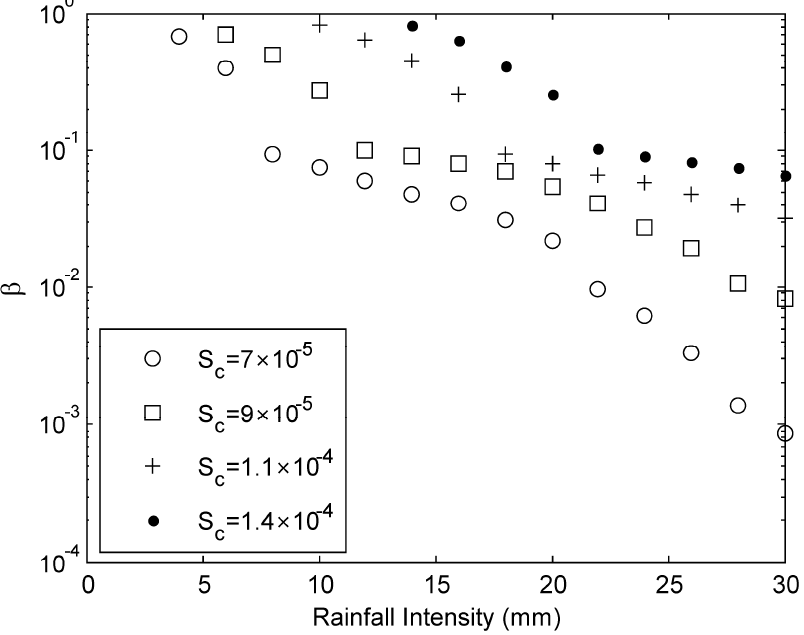
Figure 8. Corresponding Gibbsian models ( β ) to a fully looped network depending on the catchment slope and rainfall